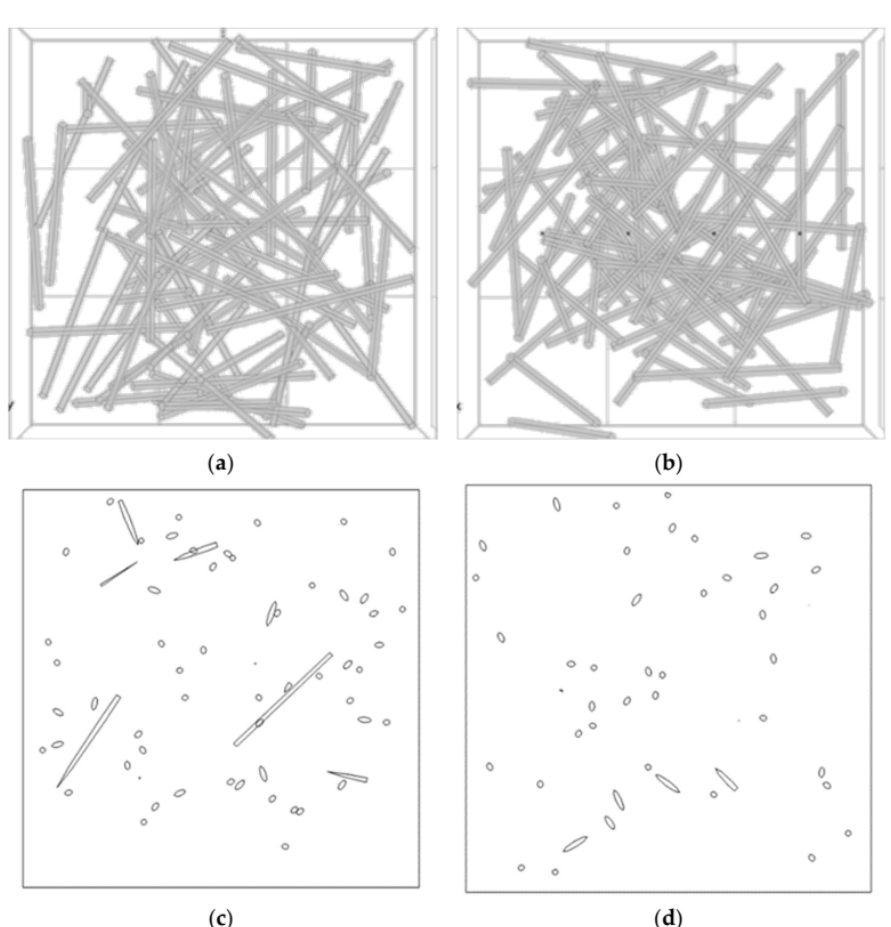
Figure 3. Simulated fiber dispersion from ( a ) top view, ( b ) side view, ( c ) section view at 50-mm height, ( d ) section view at 100-mm